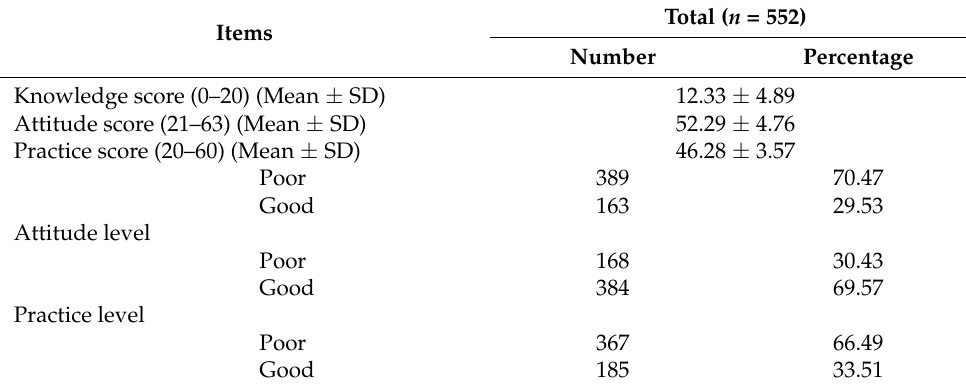
Table 3. Average scores, numbers, and percentages for knowledge, attitudes, and practices regarding soil-transmitted helminthiasis among